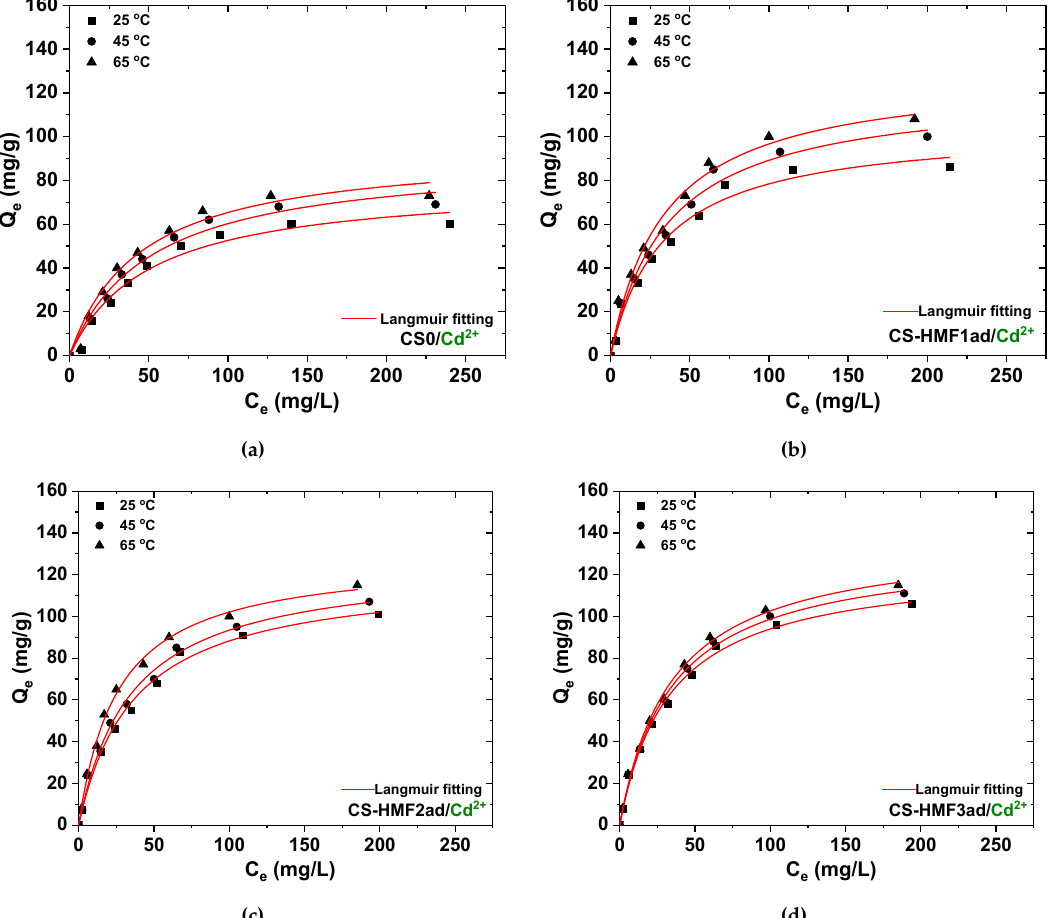
Figure 11 . Isotherms for the removal of Cd 2+ : ( a ) CSO; ( b ) CSO-HMF1ad; ( c ) CSO-HMF2ad; ( d ) Figure 11. Isotherms for the removal of Cd 2 + : ( a ) CSO; ( b ) CSO-HMF1ad; ( c ) CSO-HMF2ad; CSO-HMF3ad. Experimental conditions: C 0 = 10-300 mg/L, V = 20 mL, N = 160 rpm, T = 25, 45, 65 ( d ) CSO-HMF3ad. Experimental conditions: C 0 = 10-300 mg / L, V = 20 mL, N = 160 rpm, T = 25, 45, °C, t = 200 min, pH = 5, m = 0.02 g. 65 ◦ C, t = 200 min, pH = 5, m = 0.02 g.